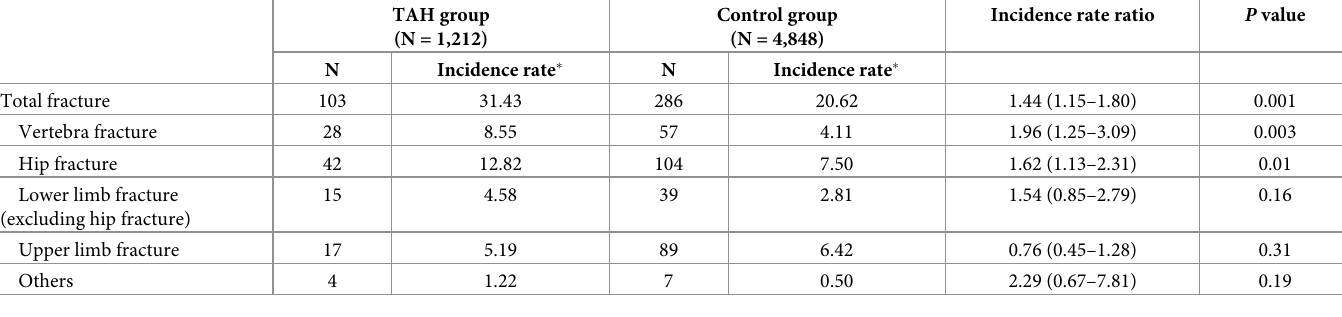
Table 2. Incident rate of fracture among thiazide-associated hyponatremia patients and control